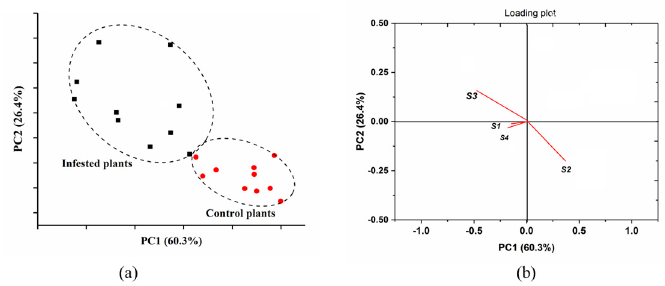
Figure 5. Principal Component Analysis (PCA) result ( a ) and loading plot ( b ) based on the E-nose data from healthy tomato plants and aphid-infested tomato plants.